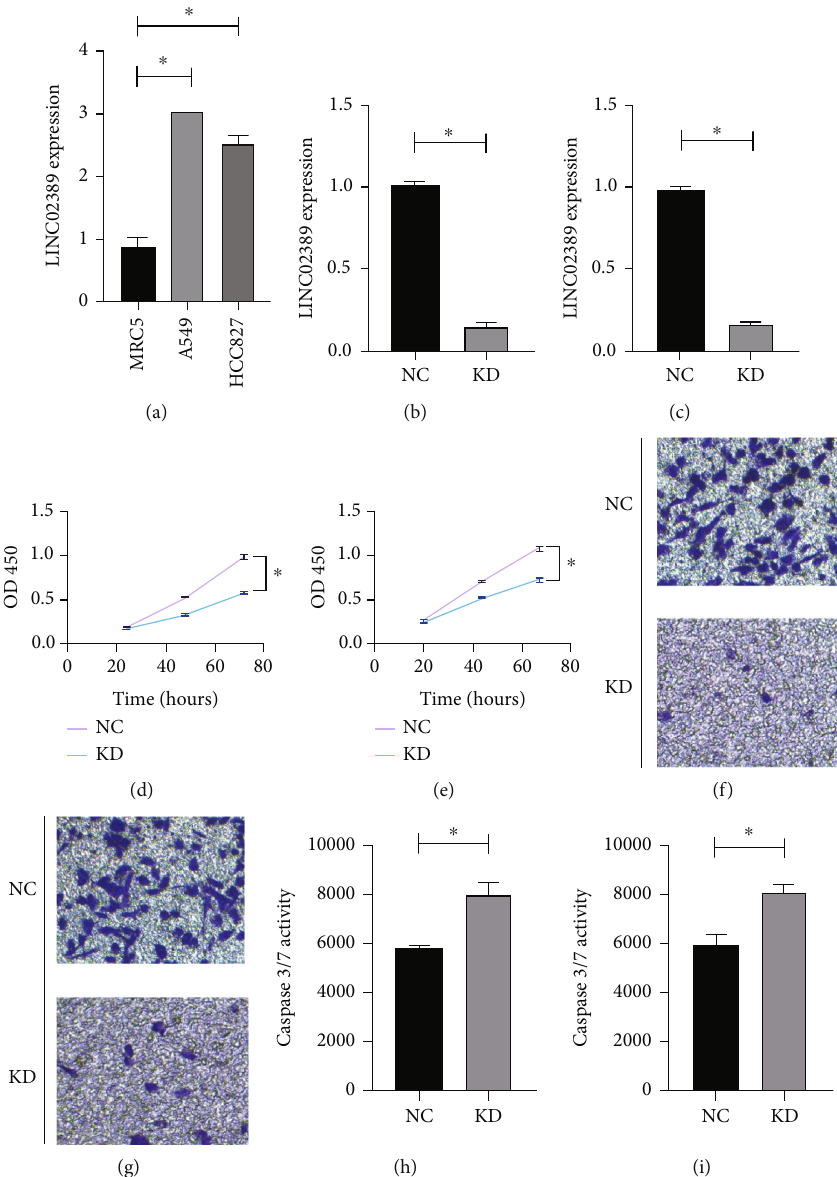
Figure 2: (a) LINC02389 expression in A549 and HCC827 cell lines compared with MRC5. (b) Knockdown of LINC02389 in A549. (c) Knockdown of LINC02389 in HCC827. (d) CCK-8 results for LINC02389 knockdown in A549. (e) CCK-8 results for LINC02389 knockdown in HCC827. (f) Transwell assay to detect the e ff ect of LINC02389 knockdown on migration ability in A549. (g) Transwell assay to detect the e ff ect of LINC02389 knockdown on migration ability in HCC827. (h) Caspase 3/7 assay to evaluate the e ff ect of LINC02389 knockdown on apoptosis rate in A549. (i) Caspase 3/7 assay to evaluate the e ff ect of LINC02389 knockdown on apoptosis rate in